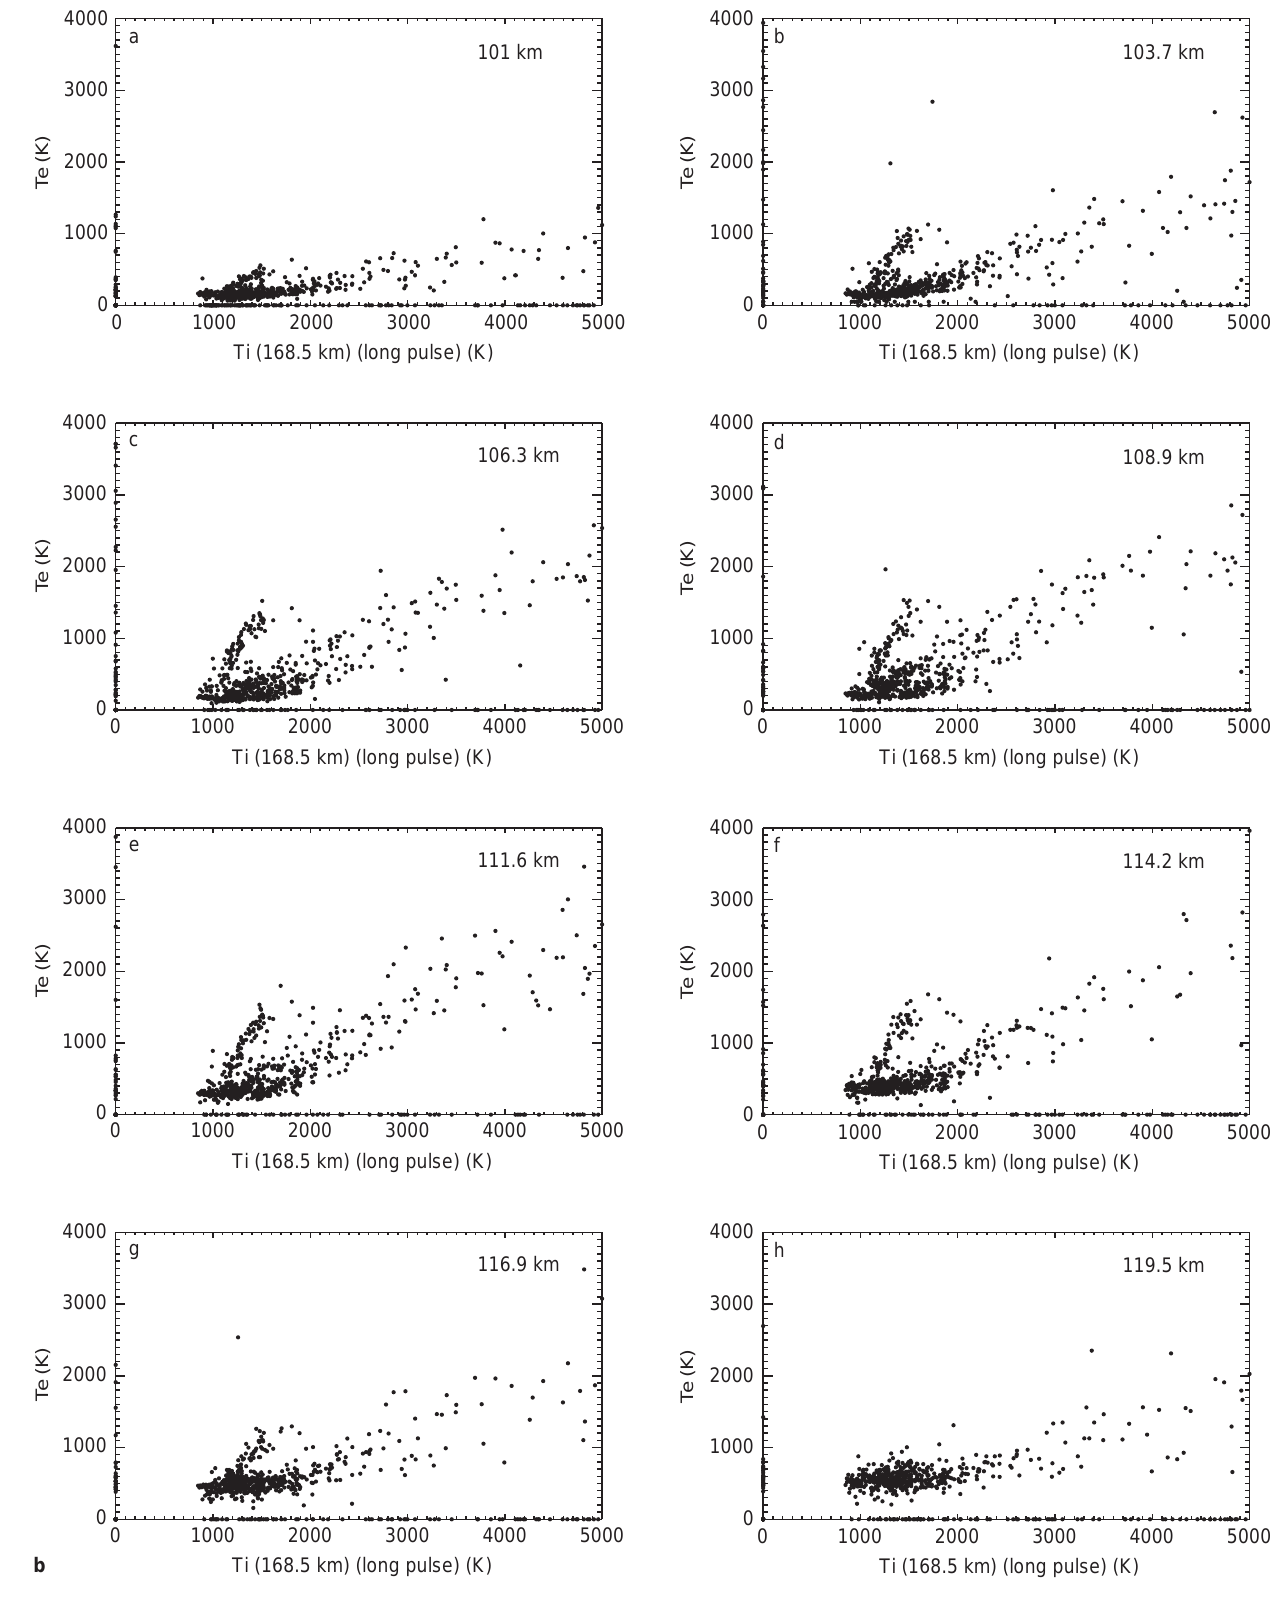
Fig. 3b. Same as Fig. 3a, but with the long-pulse T i from 168 km replacing the electric field